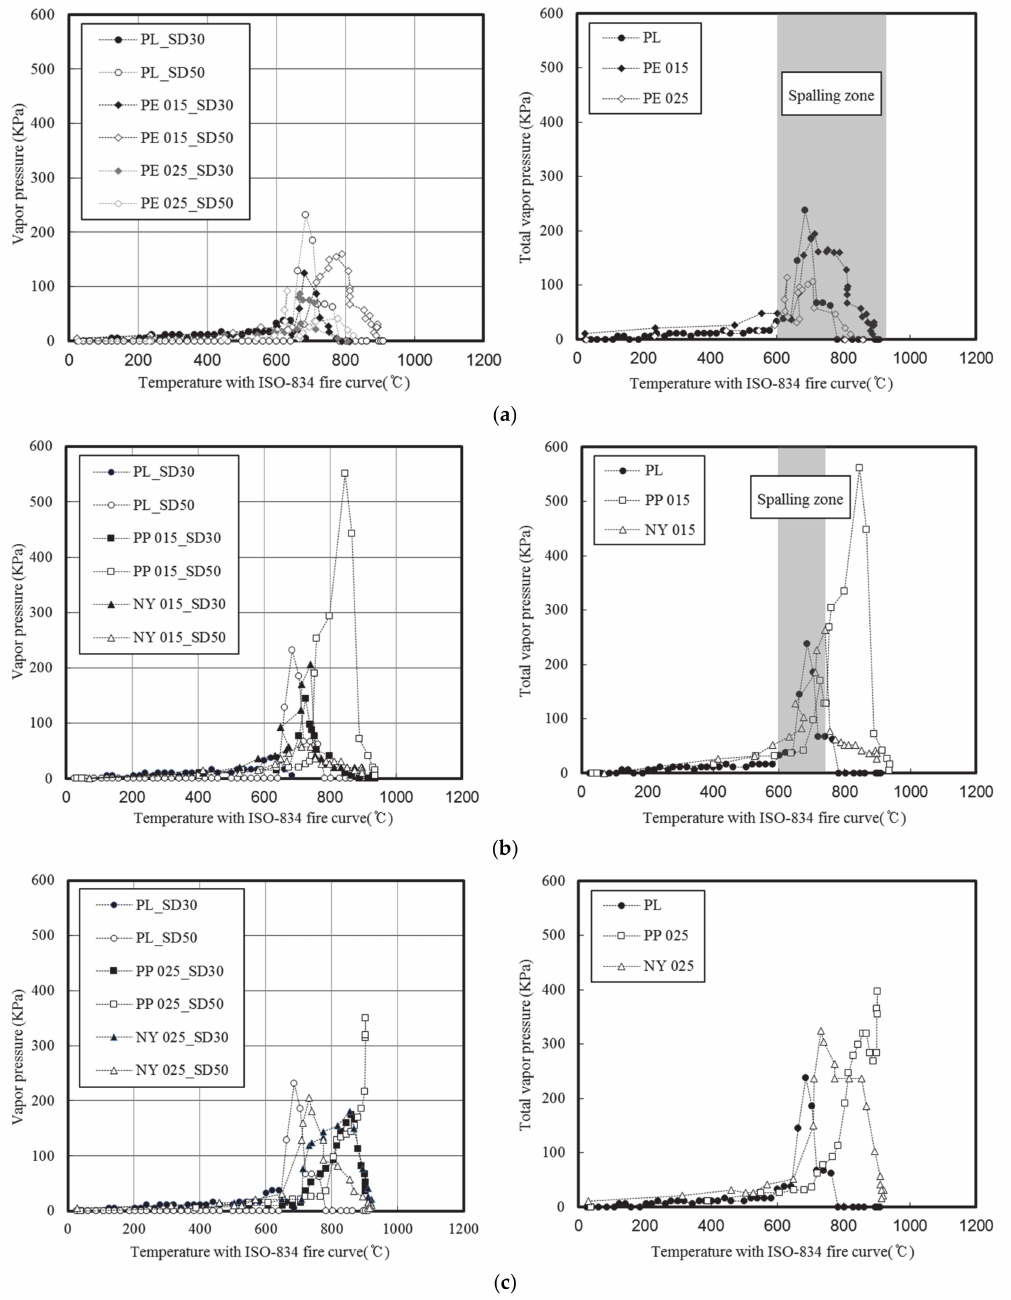
Figure 11. Water vapor pressures of the fiber-mixed concrete specimens with: ( a ) Major spalling; ( b ) minor spalling; ( c ) no